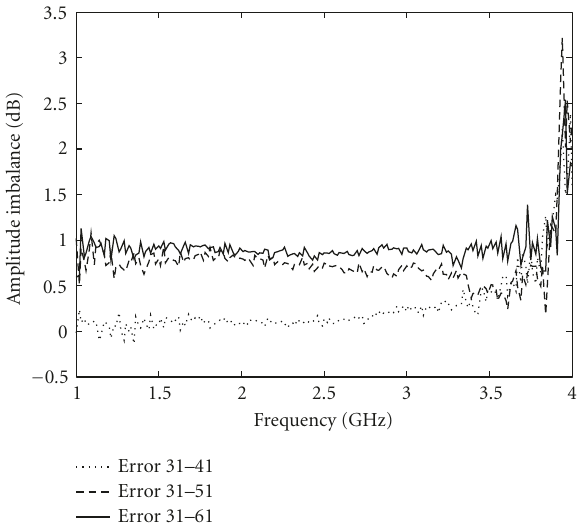
Figure 19: The measured amplitude imbalance of the 2 × 2